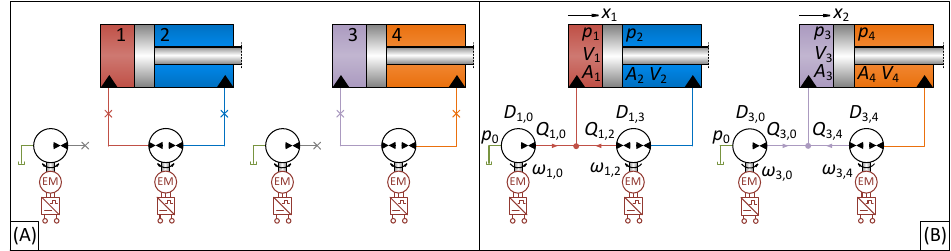
Figure 9. ( A ) Point-to-point VDN topology; ( B ) specific interconnection scheme with 0 ↔ 1 and with 0 ↔ 3.